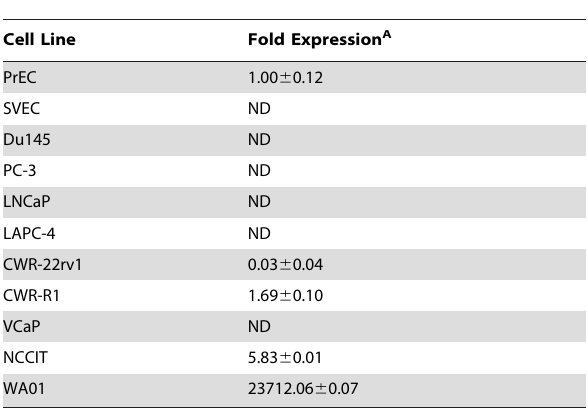
Table 1. Levels of Sox2 mRNA.